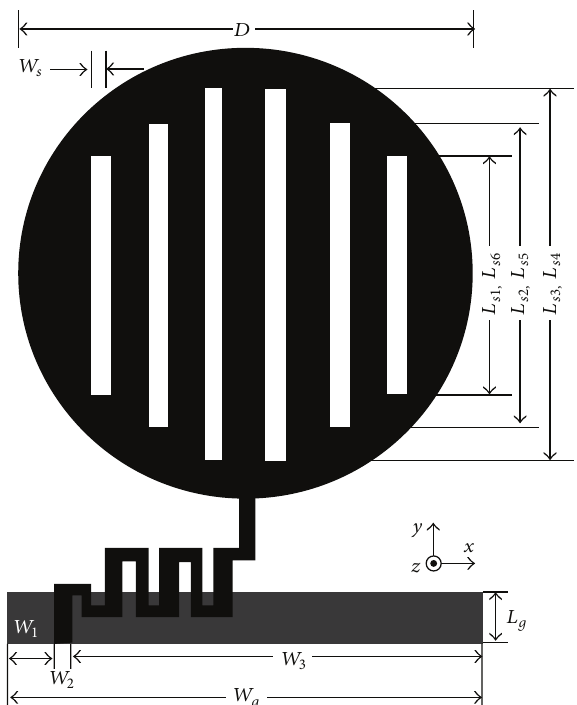
Figure 1: Geometric structure of the meandered-microstrip-fed monopole